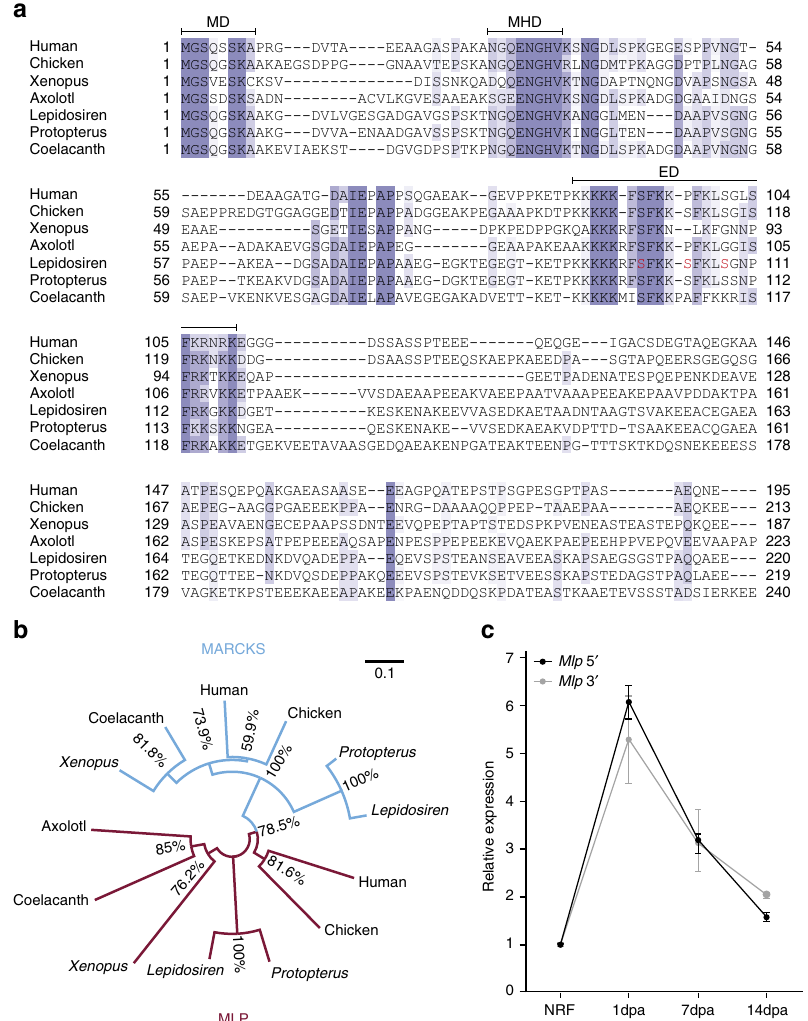
Figure 3 | Lungfish Mlp expression on regenerating fin. ( a ) Sequence alignment of MLPs as performed using a similarity matrix BLOSUM62 to compare sequences from human ( Homo sapiens ); chicken ( Gallus gallus ); frog ( Xenopus laevis ); axolotl ( Ambystoma mexicanum ); lungfishes Lepidosiren paradoxa and Protopterus annectens ; and coelacanth ( Latimeria chalumnae ). Black bars highlight the three MLP conserved domains: myristoylated N terminus domain (MD), MARCKS homology domain (MHD) and effector domain (ED). Serines in red are potential target for phosphorylation by PKC. ( b ) Phylogenetic tree of MARCKS (blue) and MLP (red) protein orthologs was inferred using the Neighbour-Joining method. Bootstrap percentage values are shown next to the branches and the evolutionary distances were computed using the p-distance method. ( c ) Relative expression for the lungfish Mlp , using two sets of primers ( Mlp 5 0 in black, Mlp 3 0 in grey), was obtained for FB, 1, 7 and 14 dpa, normalized to expression level in NRF to a relative value of 1.0 ( n ¼ 1 biological sample, three technical replicates); mean ±